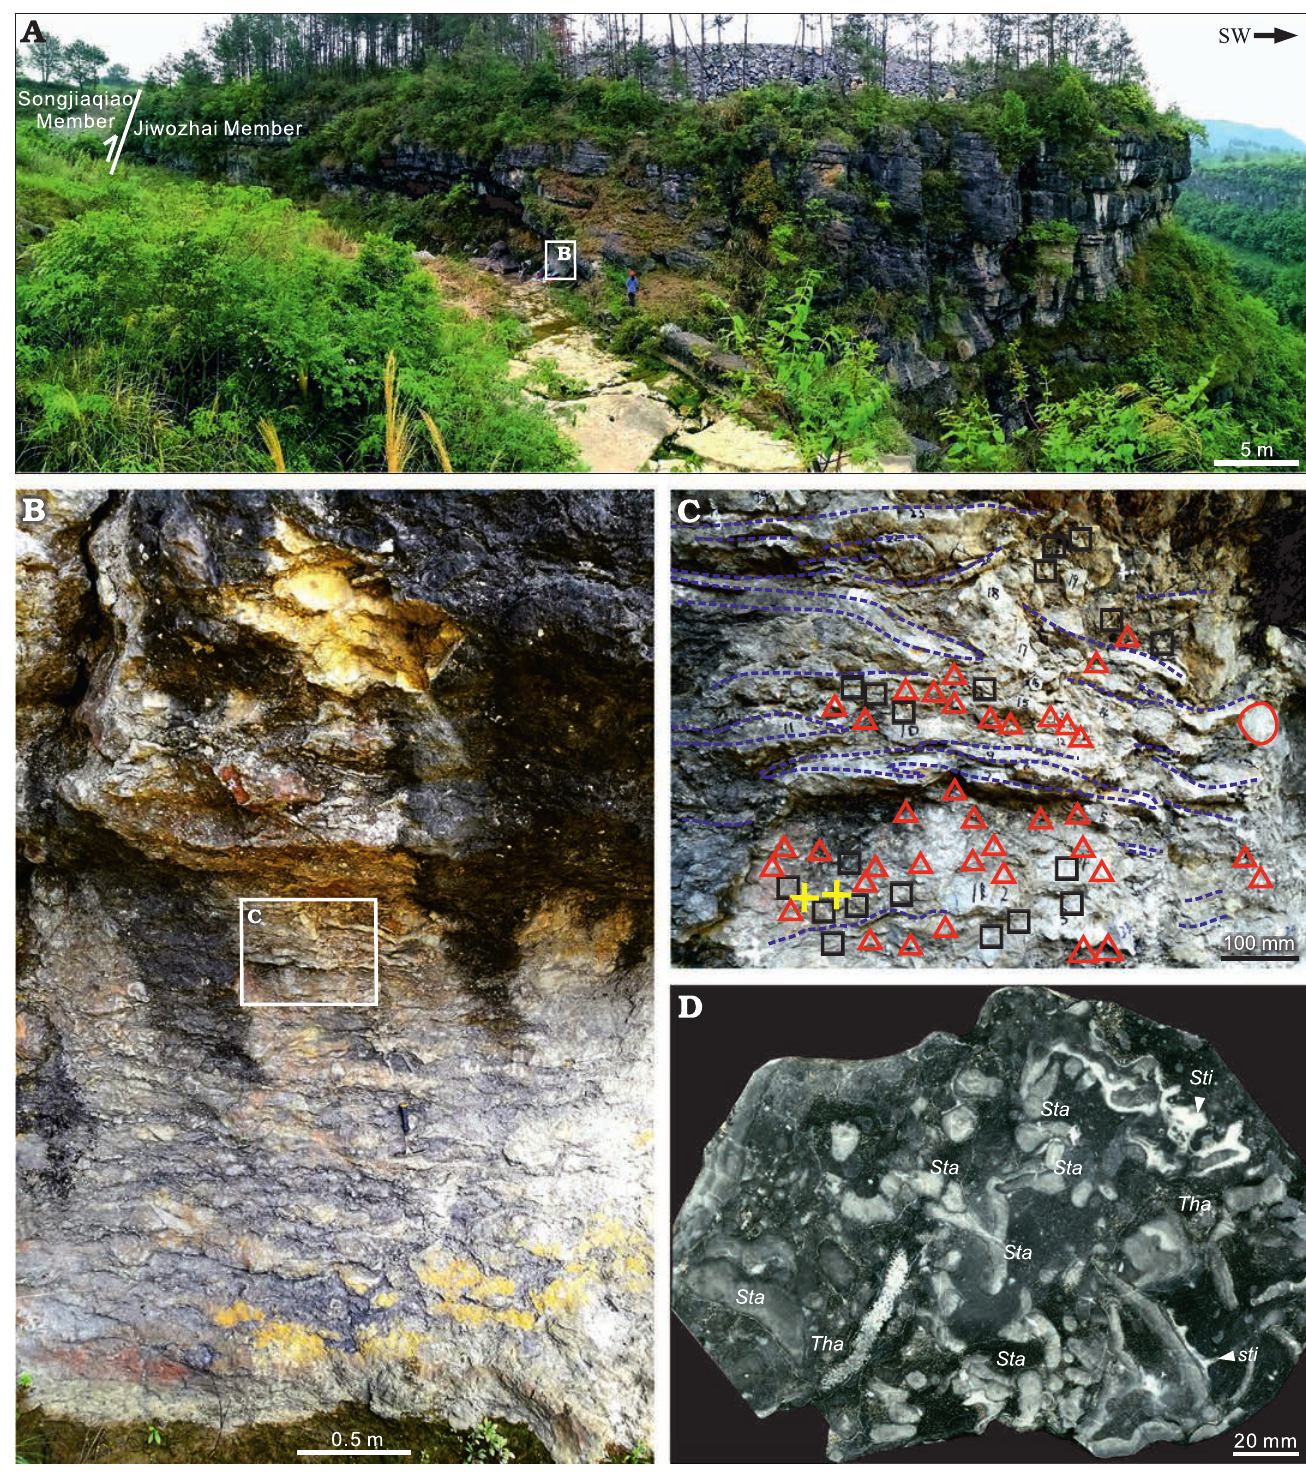
Fig. 2. Field photographs of the Jiwozhai reef. A . A panoramic view of the whole reef unit, with a white rectangle indicating the studied area. Note the reverse fault in the east. B . A general view shows the studied area of the reef unit. C . Enlarged field photo of the reef fragment marked in B, showing the thick or thin laminar stromatoporoids (undulating dashed line) covered on branching tabulate corals (triangles), solitary rugose corals (crosses), dendroid stromatoporoids (squares), bulbous stromatoporoid (circled line), and clay-rich micrites (fine grained sediments between the metazoan skele- tons). D . An example of polished block of the Jiwozhai reef limestone showing toppled dendroid or laminar Stachyodes fasciculata Dong in Dong et al., 1989, and encrusting Stictostroma saginatum (Lecompte, 1951) in the upper area. Note the conspicuous digitation of mamelons of Stictostroma saginatum (Lecompte, 1951) in the lower right corner. Sti , Stictostroma saginatum (Lecompte, 1951); Sta , Stachyodes fasciculata Dong in Dong et al., 1989; Tha , Thamnopora cf. pansiensis Tchi,